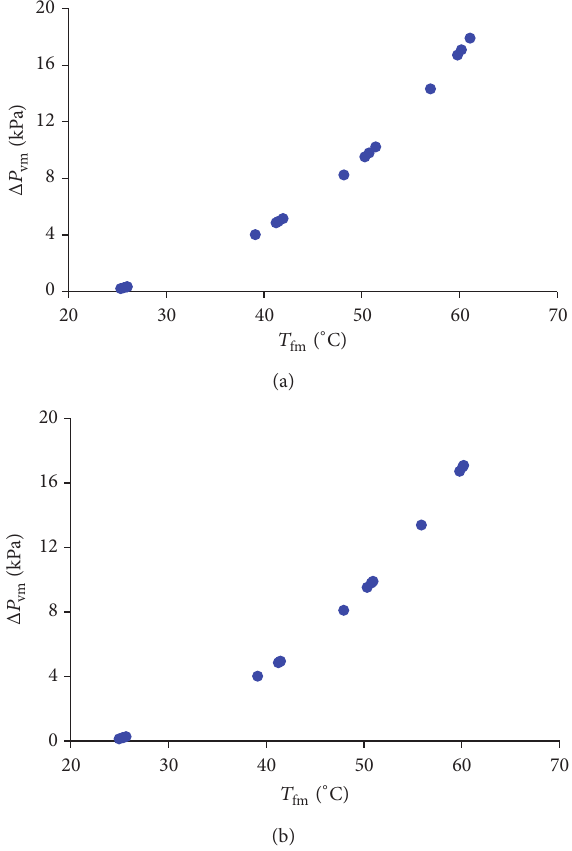
Figure 8: The variations in the membrane surface temperature 𝑇 fm with the vapor pressure difference Δ𝑃 vm for the (a) PVDF and (b) PTFE